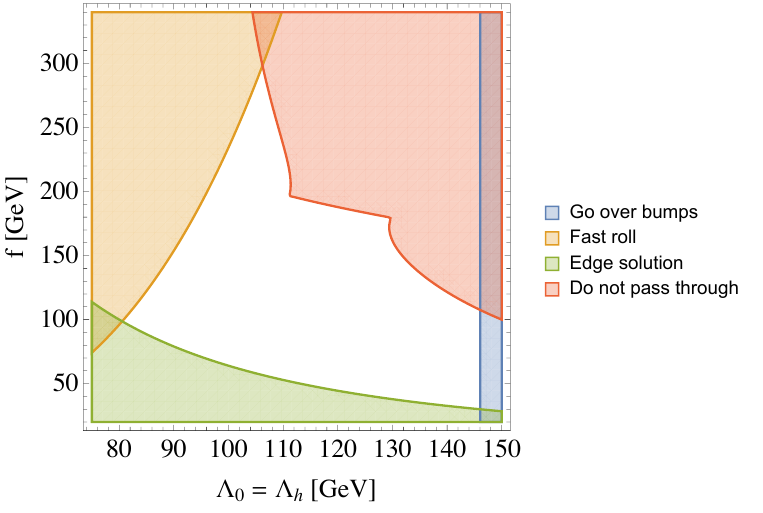
Figure 5 . The conditions for the successful relaxation. We plot only the strongest ones. The blue shaded region around the right edge is excluded by \Go over bumps" condition. The orange shaded region around the upper left corner is excluded by \Fast roll" condition. The green shaded region around the bottom left corner is excluded by \Edge solution" condition. The red shaded region around the upper right corner is excluded by \Do not pass through"